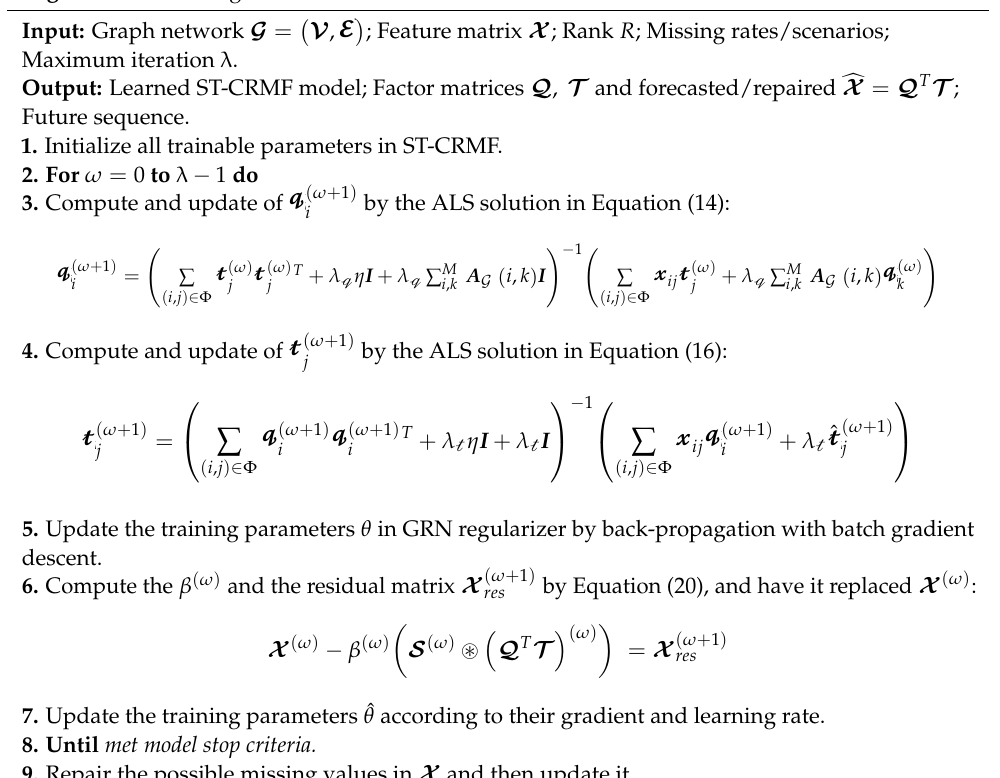
Figure 2. Schematic of the spatial-temporal matrix factorization (white boxes denote missing data).